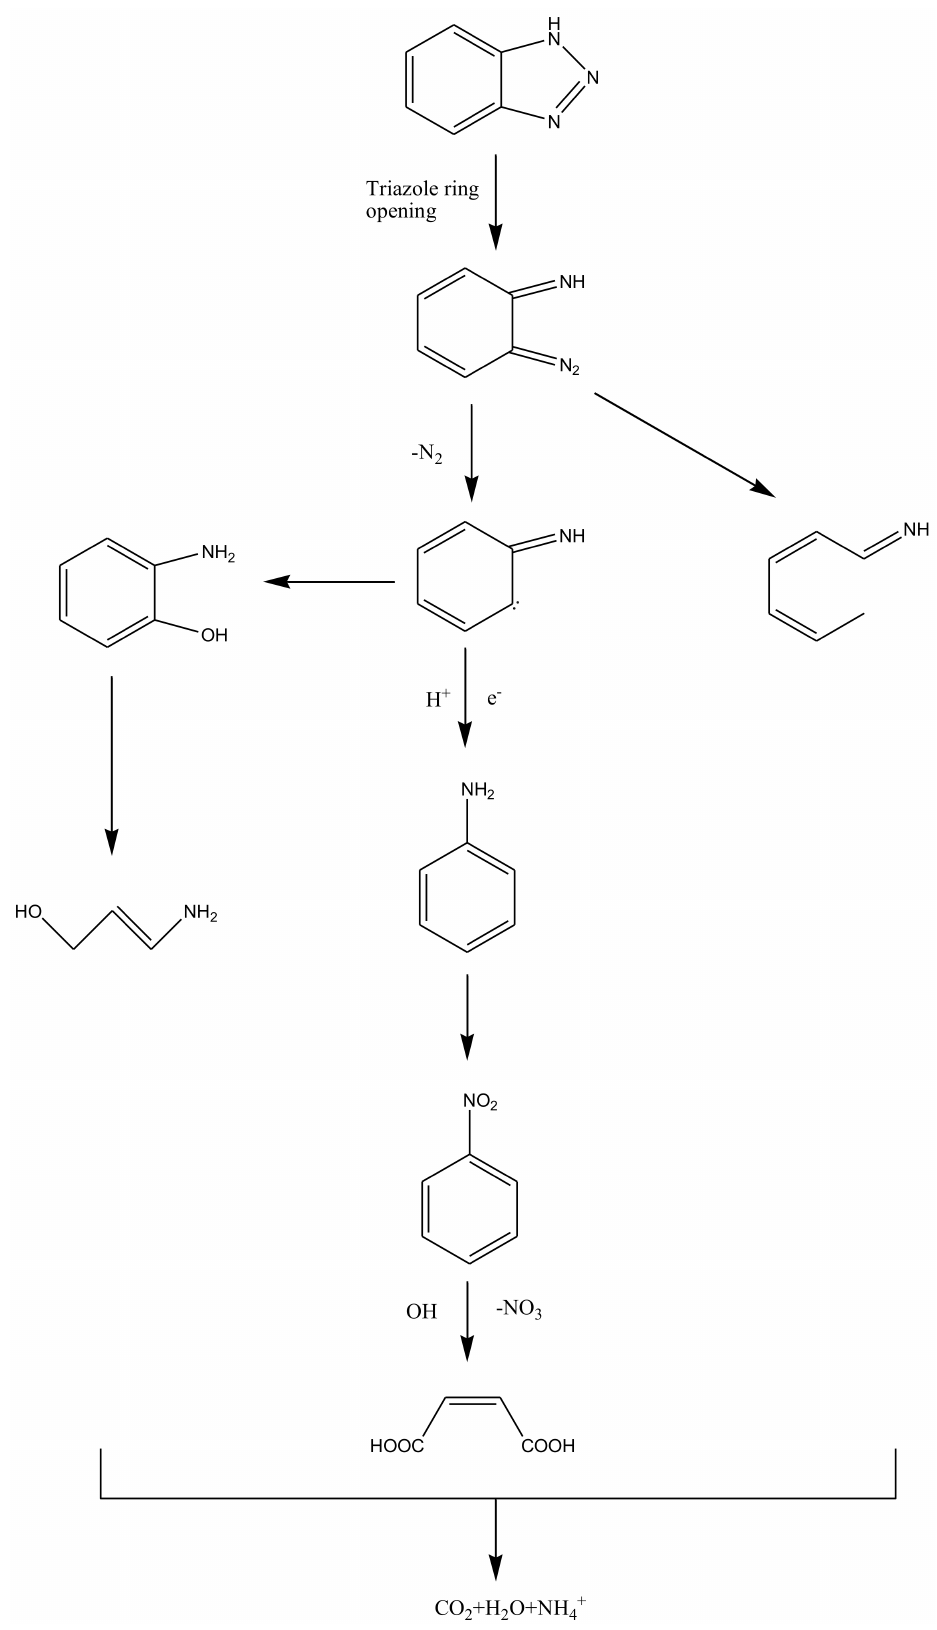
Figure 13. Conceivable photodegradation pathway of BZT under simulated sunlight irradiation with BiSnSbO 6 as